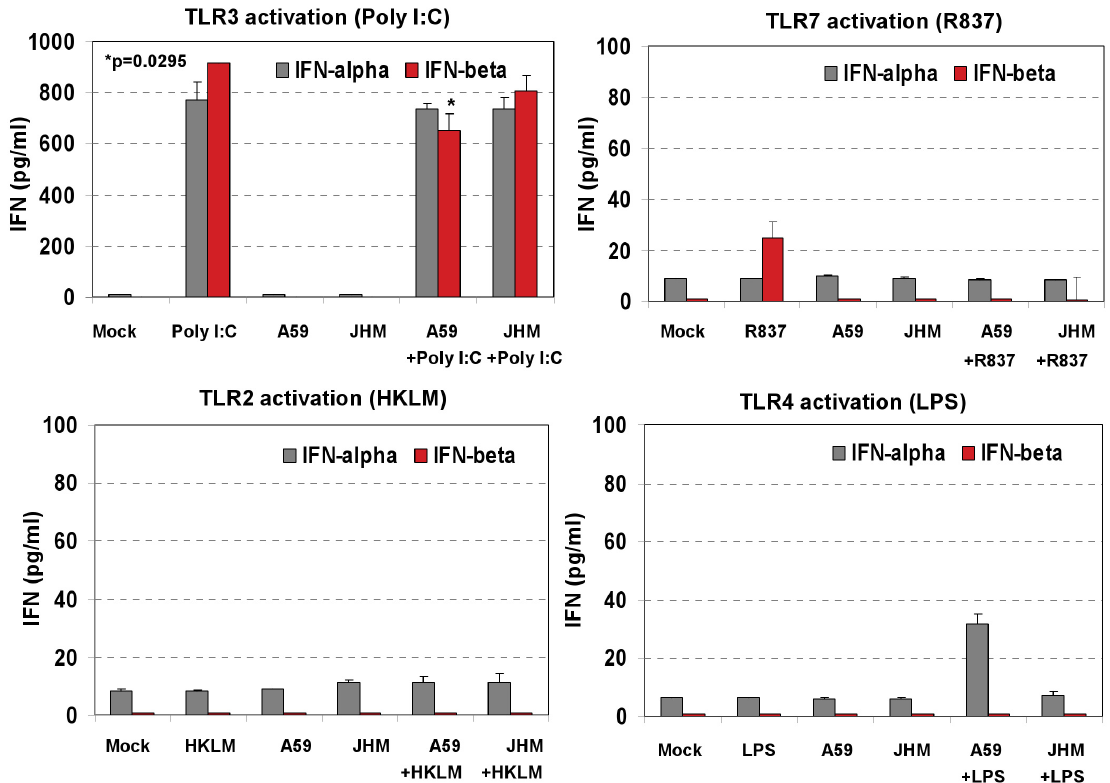
Figure 6. Type I IFN production in cell-free supernatants from J774A.1 macrophages stimulated with TLR ligands, MHV-infected, and/or coactivated during MHV infection. J774A.1 cells were prestimulated for 6 h with HKLM (10 8 cells/mL), LPS (5 μ g/mL), R837 (5 μ g/mL), and poly I:C (0.25 μ g/mL); media was removed and: (1) a second challenge of the corresponding TLR ligand (same concentrations) was added to the cells for 18 h; (2) cells were prestimulated for 6 h with the TLR ligands as above; media was removed and cells infected with MHV-A59 or MHV-JHM at 1.0 MOI for 1 h of adsorption in the absence of the ligands; after virus adsorption cells were stimulated with a second challenge of the TLR ligands using the same concentrations as during prestimulation and samples were taken at 18 h; (3) cells were not TLR activated and only infected with MHV-A59 or MHV-JHM at 1.0 MOI for 1 h of adsorption in the absence of the ligands; fresh media was added to the cells for 18 h. Non-stimulated, non-infected J774A.1 cells were used as mock control. Cell-free supernatants were taken at 18 h from TLR-activated alone, infected alone, and TLR-activated and infected and assessed for IFN- α and IFN- β production using ELISA. Error bars represent the standard error of the mean of two independent experiments, each done in duplicate; * p < 0.05, Student’s t